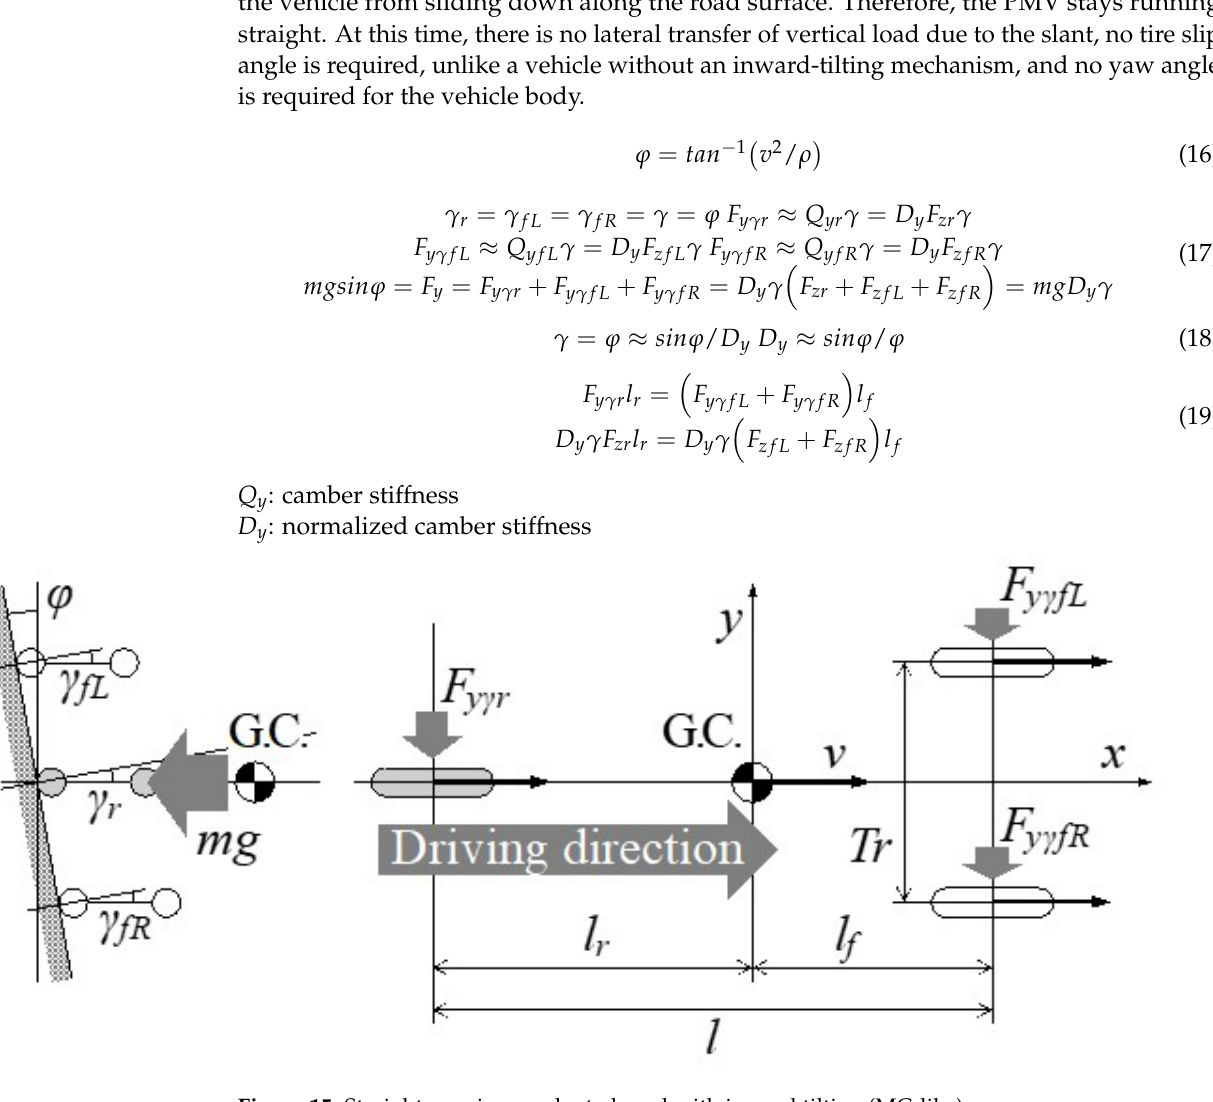
Figure 15. Straight running on slanted road with inward tilting